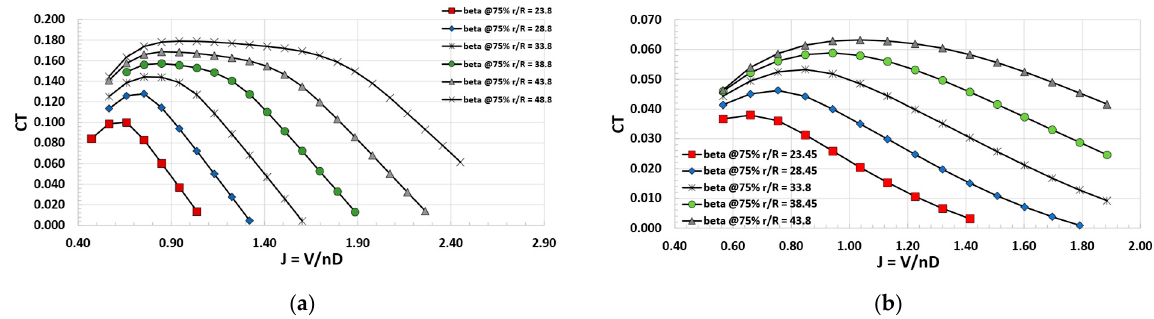
Figure 12. Propellers thrust coefficient map (different blade pitch angles). ( a ) Tip propeller. ( b ) DEP propeller.